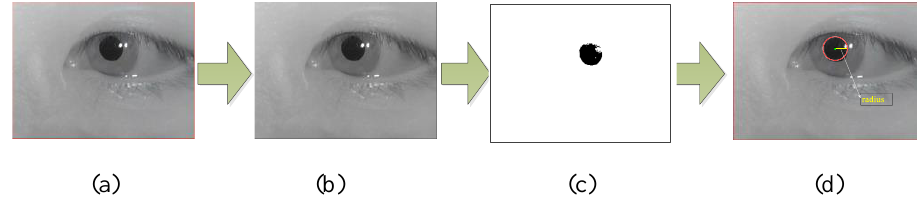
Figure 7. The process of extracting the pupil diameter. ( a ) The original eye movement frame picture; ( b ) the grayscale image; ( c ) the binary image, and ( d ) the diameter and the center of the pupil using the Hough transform.